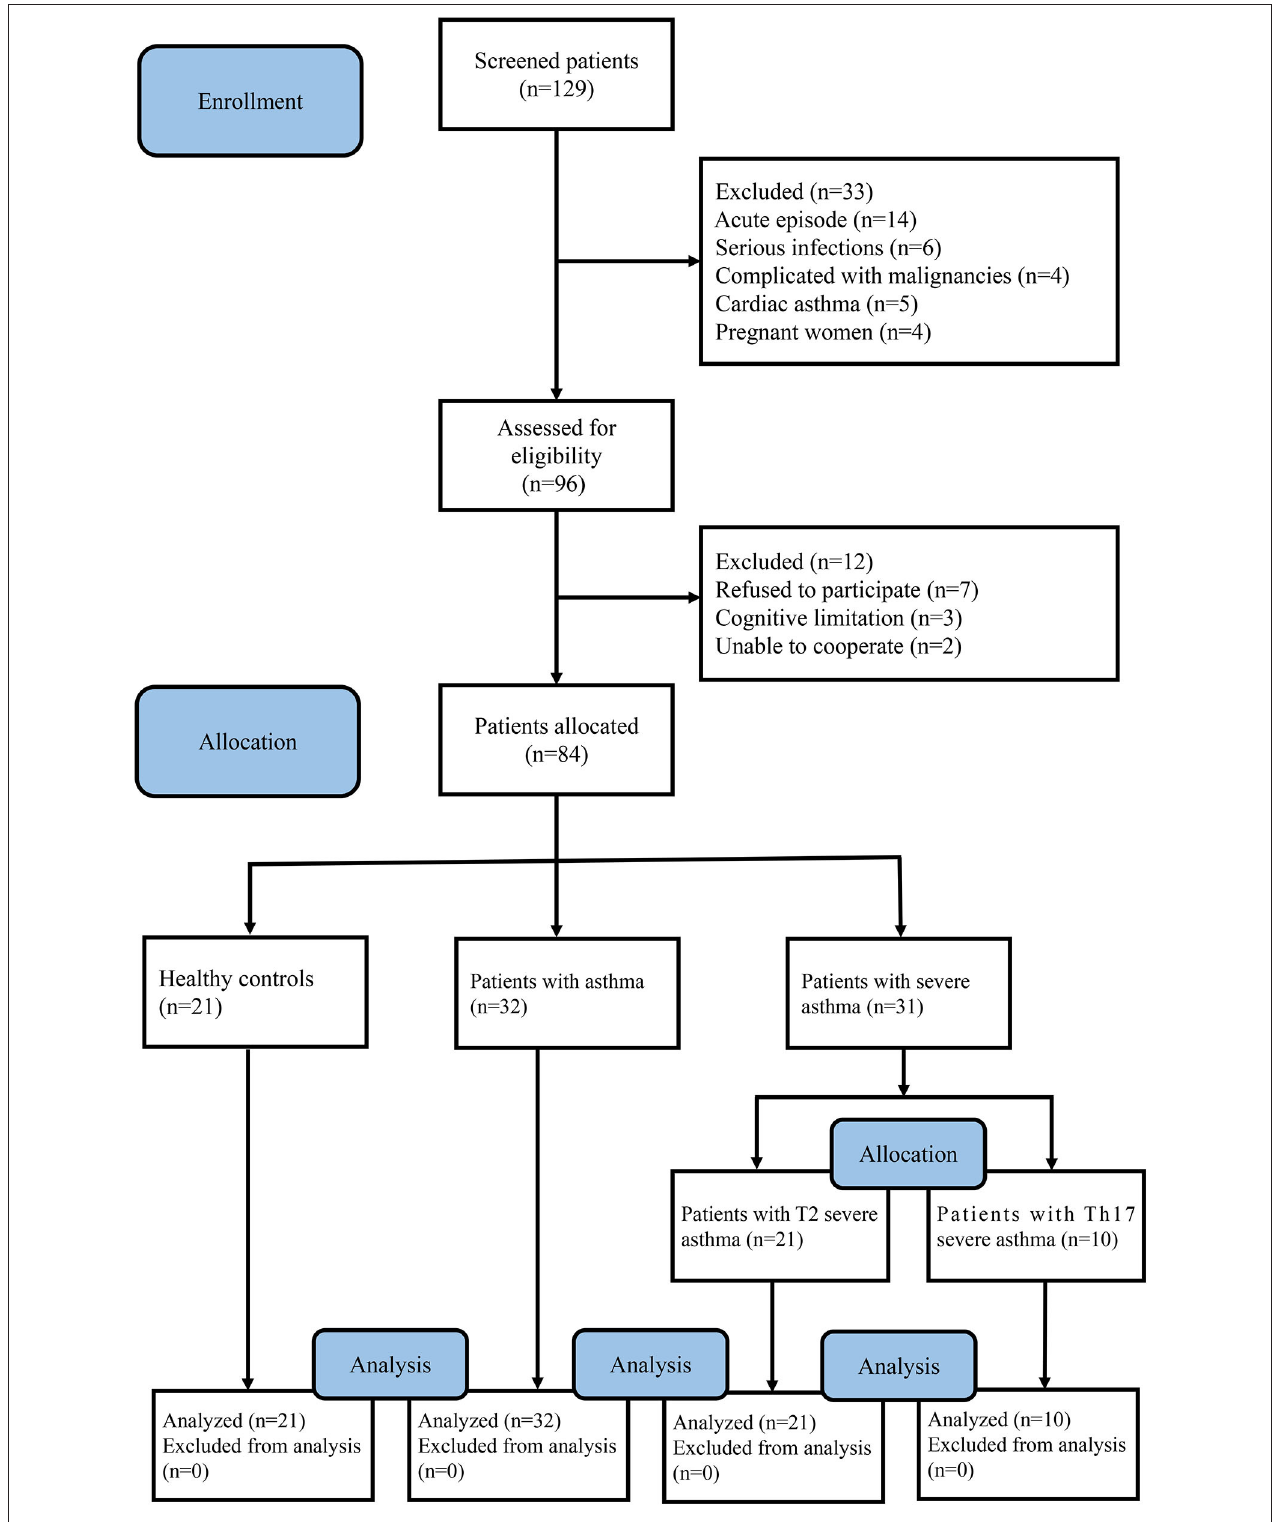
FIGURE 1 | Flow diagram of the